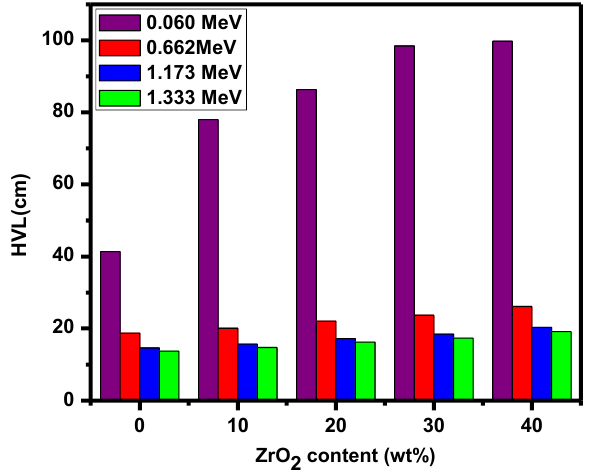
Figure 7. The variation of the radiation absorption ratios of epoxy with ZrO 2 . The effective atomic number (Z eff ) of the epoxy composites were computed using Phy-X software. For the Z eff values, we not only selected the four energies used in the previous figures, but we extend the energy range up to 15 MeV. The variations of the Z eff values of the epoxy composites without ZrO 2 and with ZrO 2 was determined using Phy-X software, and these have been graphed in Figure 8. The general trend of the Z eff values versus the energy is the same for each of the epoxy composites. The Z eff values show increased behavior between 0.015 MeV and 0.02 MeV (standard for EBZr-0), and this is due to the K-absorption edge for Zr which occurs at 0.018 MeV, and because EBZr-0 is ZrO 2 -free, so we didn’t observe this increase in the Z eff trend between 0.015 MeV and 0.02 MeV. Between 0.02 MeV and 0.3 MeV, the Z eff values decreased, and the rate of this decrease was very fast. For EBZr-10, the Z eff in this interval varied between 27.15 and 4.75, while it is varied between 29.07 and 4.67 for EBZr-20. Above 0.3 MeV and up to around 5 MeV, the Z eff values remained constant for all epoxy composites regardless of their ZrO 2 content. Moreover, as the ZrO 2 content increased in the epoxy composites, the Z eff values also progressively increased. This increase in the Z eff values may be associated with the increase in the weight percentage of high Z-elements (i.e., Zr with atomic number of 40). Thus, we found significant differences in the Z eff values between the EBZr-0 and EBZr-40 composites. Quantitatively, the Z eff values for these composites were, respectively, 8.66 and 39.70 at 0.02 MeV, 4.74 and 25.00 at 0.06 MeV, 4.27 and 8.22 at 0.2 MeV, and 4.25 and 6.57 at 0.6 MeV.